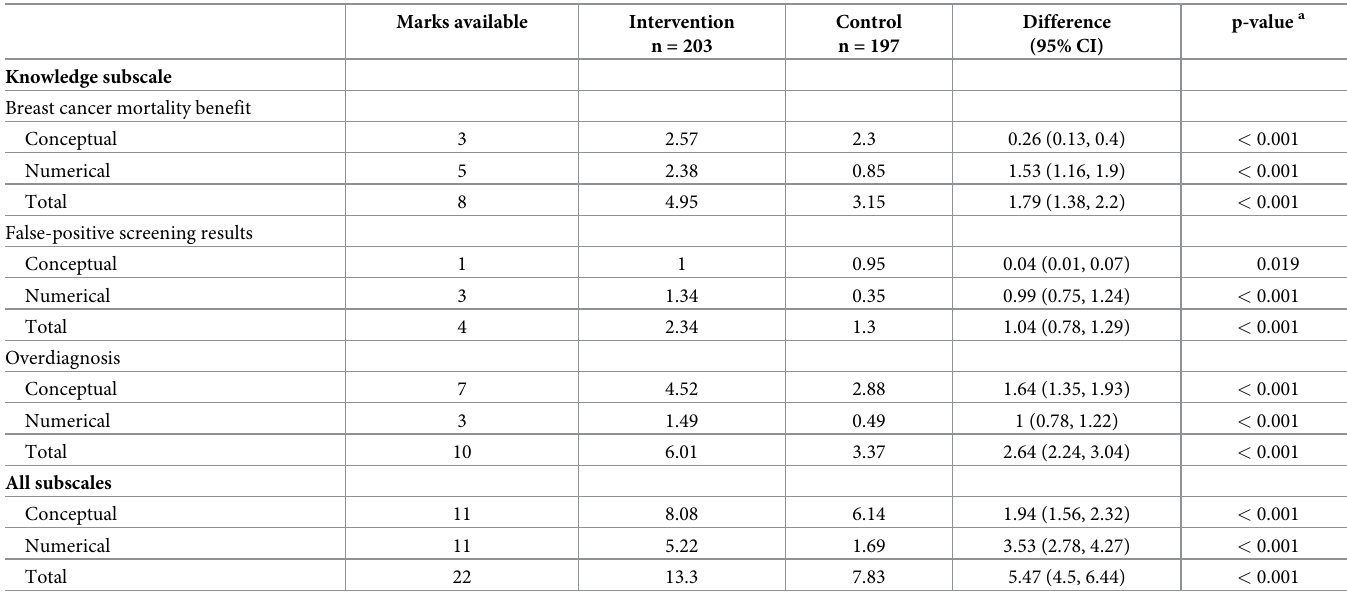
Table 3. Mean scores on knowledge subscales.